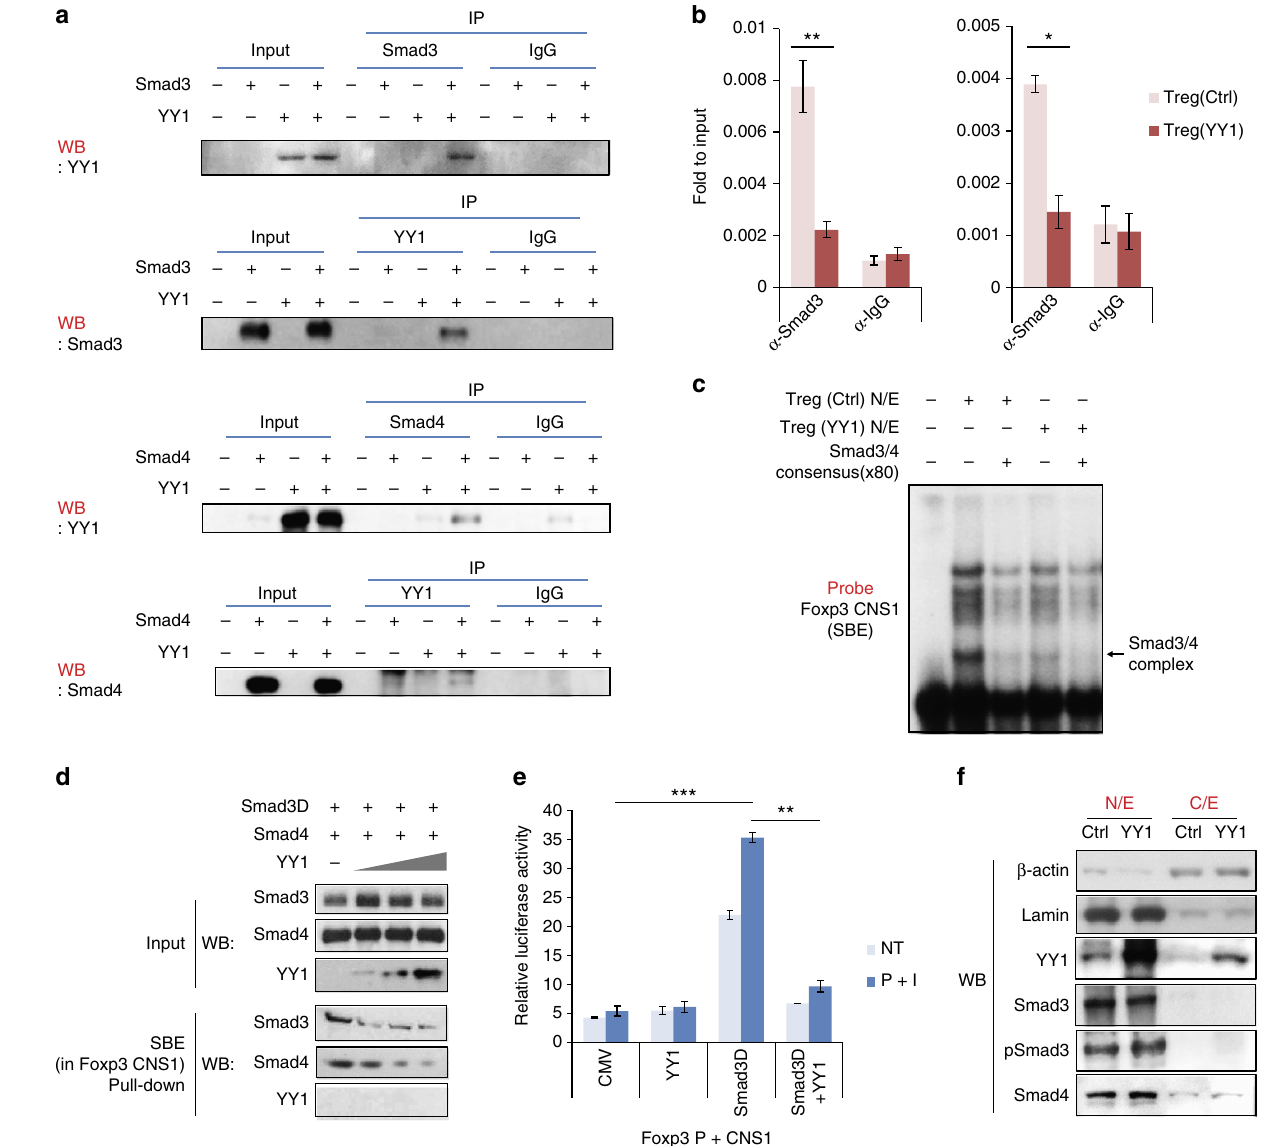
Figure 6 | YY1 inhibits expression of Foxp3. ( a ) HEK293T cells were transfected with Smad3 -, Smad4 - or Yy1 -expression vector. Cell lysates were immunoprecipitated with an anti-Smad3, anti-Smad4, anti-YY1 or control IgG antibody. Then, proteins were immunoblotted with an anti-Smad3, anti-Smad4 or anti-YY1 antibody. IP, immunoprecipitation; WB, immunoblot. ( b ) Binding of Smad3 and Smad4 to the Foxp3 CNS1 in control or YY1-expressing T reg cells was measured by ChIP assay. ( c ) Binding of Foxp3 to Smad-binding element (SBE) in the Foxp3 CNS1 was detected by EMSA using control or YY1-expressing T reg nuclear extracts. Competition assay was performed with Smas3/4 consensus sequence (x80). Arrows indicate Smad3/4-SBE complexes. ( d ) Nuclear extracts overexpressing Smad3 and Smad4 with increasing amounts of YY1 were mixed with SBE of the Foxp3 CNS1, and DNA pull-down assay were performed. Oligo-dTwas used as a negative control. ( e ) Transactivation activity of the Foxp3 promoter by Smad3 and YY1 was measured by transient reporter assay. EL4 cells were transfected with Foxp3 promoter-CNS1-luc reporter construct in the absence or presence of Smad3D- (constitutively active form of Smad3) and/or Yy1- expression vector. I, ionomycin; NT, no treatment; P , phorbol 12-myristate 13-acetate. ( f ) Nuclear extract (N/E) and cytosolic extract (C/E) were isolated from control T reg cells or YY1-transduced T reg cells. Relative amounts of YY1, Smad3, pSmad3 and Smad4 in N/E and C/E were measured by immunoblot analysis. b -Actin and Lamin were used as loading controls. Statistical differences in b , d and e were analysed by Student’s t -test ( n ¼ 3). * P o 0.05. ** P o 0.01. *** P o 0.001. Error bars shown in b , d and e represent